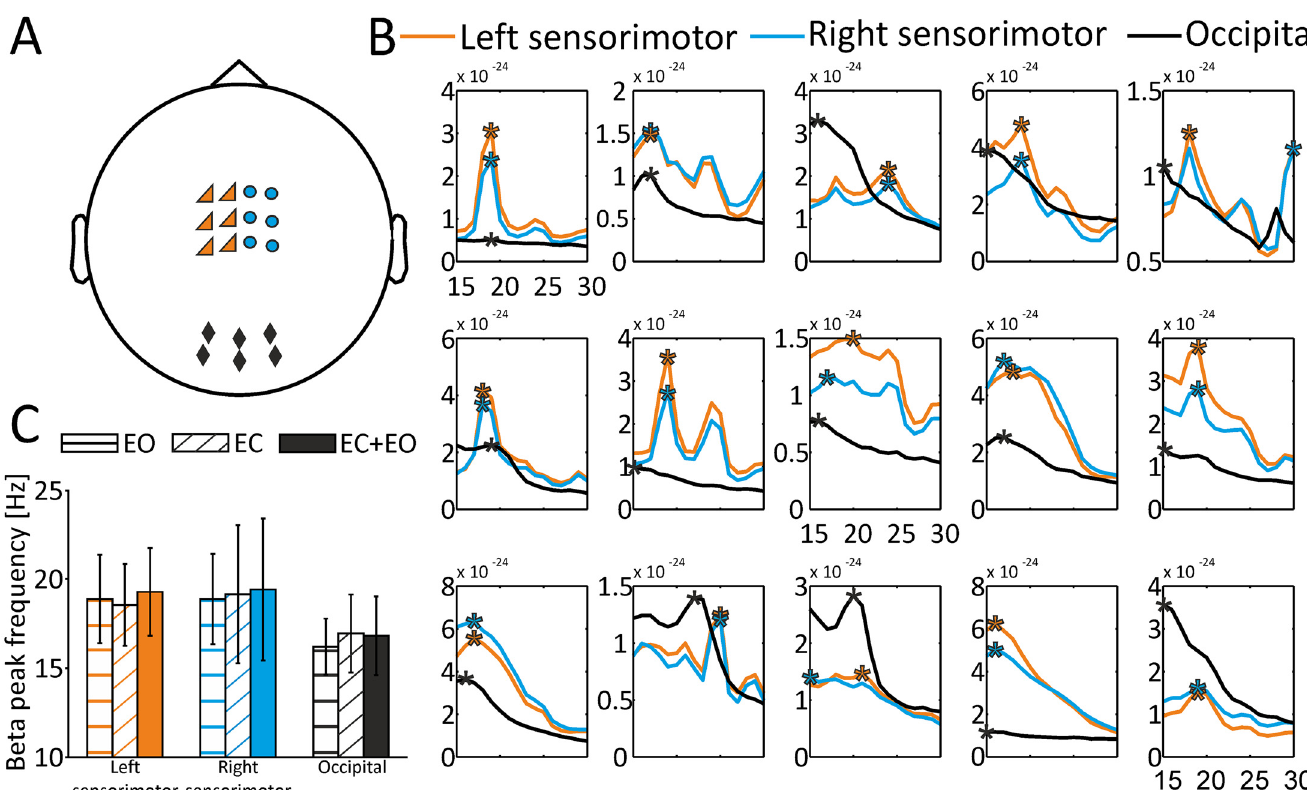
Fig 2. Sensor selection for respective MEG ROIs, individual beta peak frequencies and average beta peak frequencies across MEG ROIs. A) Sensors for left sensorimotor MEG ROI (orange triangles), right sensorimotor MEG ROI (blue dots) and occipital MEG ROI (black diamonds). B) Individual beta peak frequencies for all 15 subjects (EC+EO condition) for left sensorimotor MEG ROI (orange lines), right sensorimotor MEG ROI (blue lines) and occipital MEG ROI (black lines). Individual beta peak frequencies are highlighted by asterisks. C) Average beta peak frequencies separately for all conditions (EO, EC, EC+EO) and all MEG ROIs. Error bars represent standard deviations.